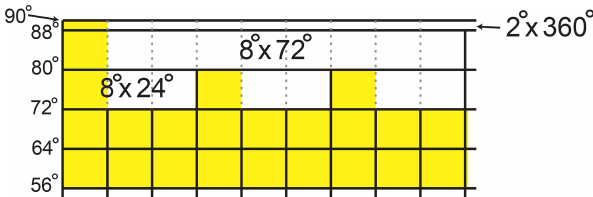
Figure 5. The larger root nodes north and south of 72 ◦ are implicit. Only the nodes colored yellow contain pointers to metagrid sub-